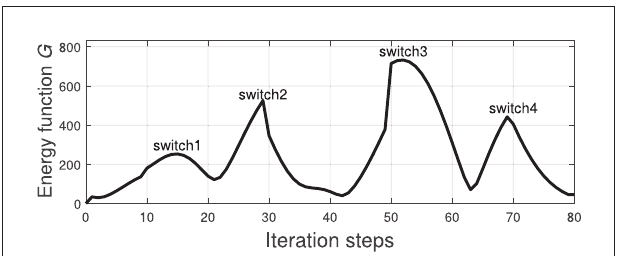
FIGURE 5 | Profile of the function G that is computed along the circular trajectory passing through the points in Figure 4 ; The “switch” label indicates the instant when A l t switches to different b